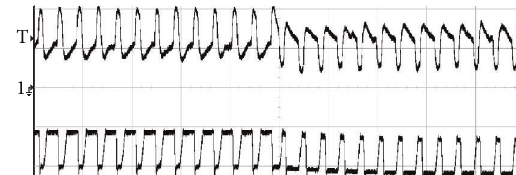
Figure 5: Upper trace: oscilloscope capture at the output of the first (current to voltage converter) stage. It is shown that the low frequency content is lost and the waveform is weighted above and below the zero mean value. Lower trace: output of the second (inverting voltage comparator) stage. The waveform is restored in to its original (two) levels.